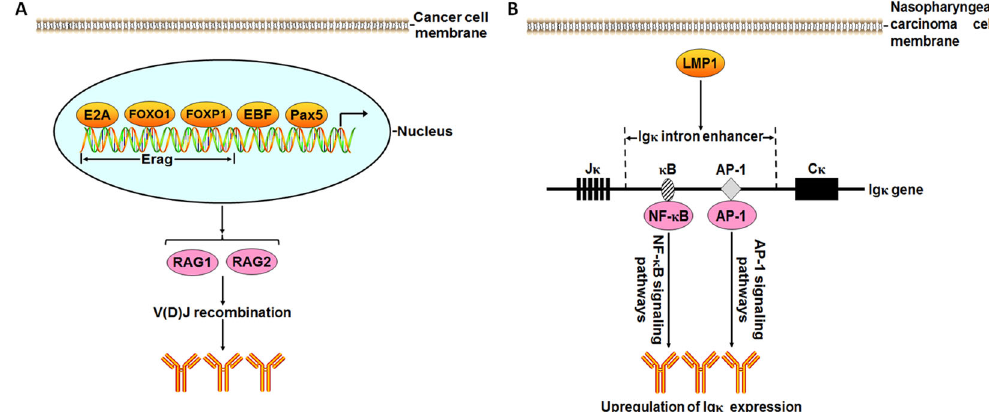
Fig. 2 Schematic illustration of the regulatory mechanisms of tumor-derived Ig expression. A The transcription factors (E2A, FOXO1, FOXP1, EBF, and Pax5) bond to Erag and other RAG promoters to activate transcription of RAG1 and RAG2, which in turn promoted